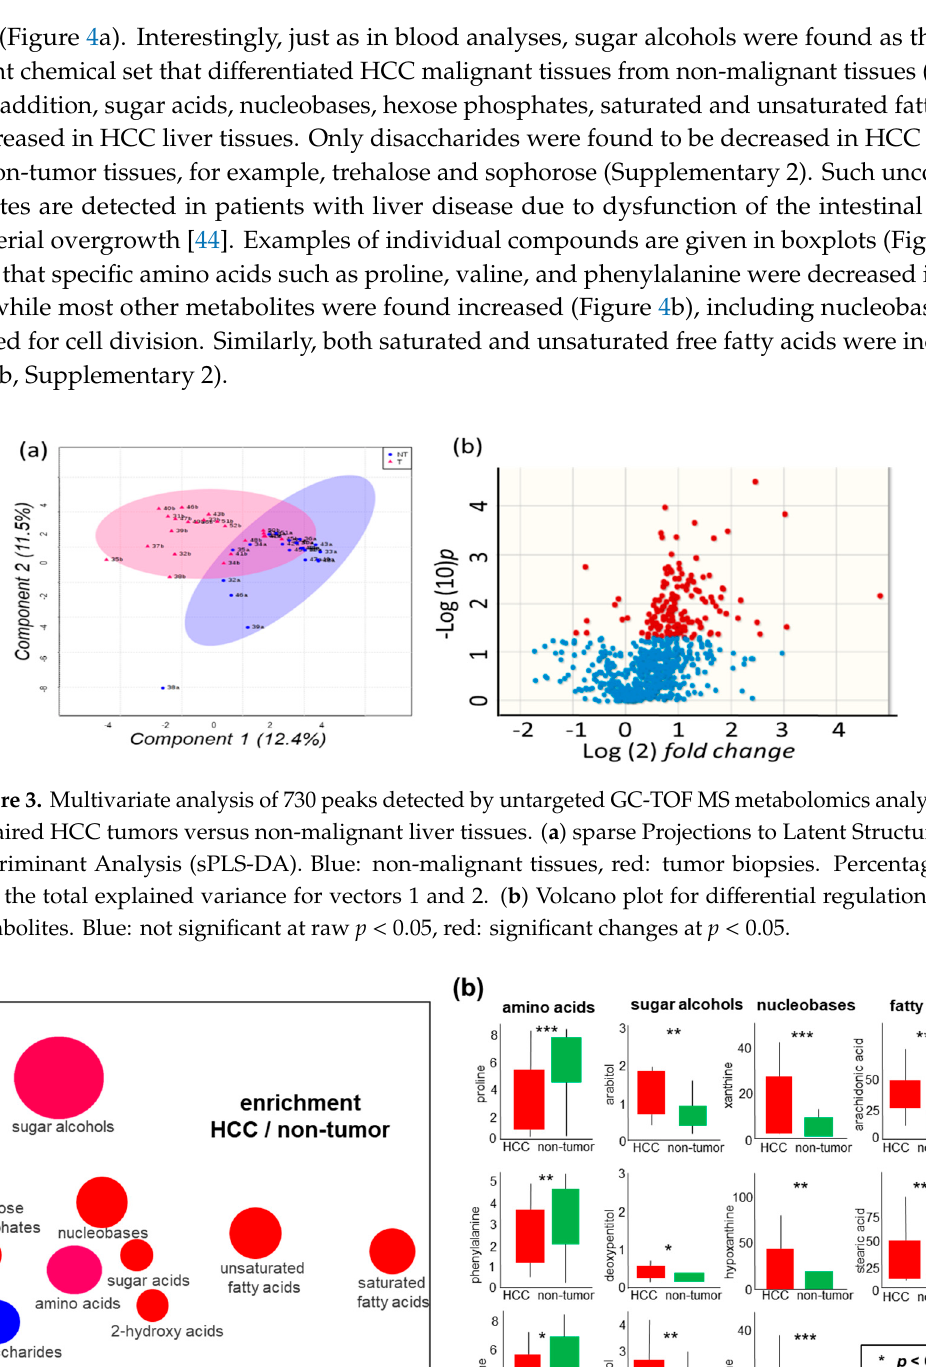
Figure 4. Di ff erential regulation of liver metabolites in HCC tumors versus non-malignant tissues. ( a ) Chemical set enrichment statistics of significantly regulated metabolites. Colors of chemical sets: red = increased, blue = decreased, purple = sets with compounds decreased and increased. Ball sizes represent the number of compounds per metabolic set. XlogP represents the median lipophilicity of the metabolic clusters. ( b ) Examples of boxplots (medians and interquartile ranges) of individual compounds that showed univariate significant di ff erences. Units of all y-axes: normalized peak intensities in 10,000 ion counts / spectrum for each quantification ion (Supplementary S1).